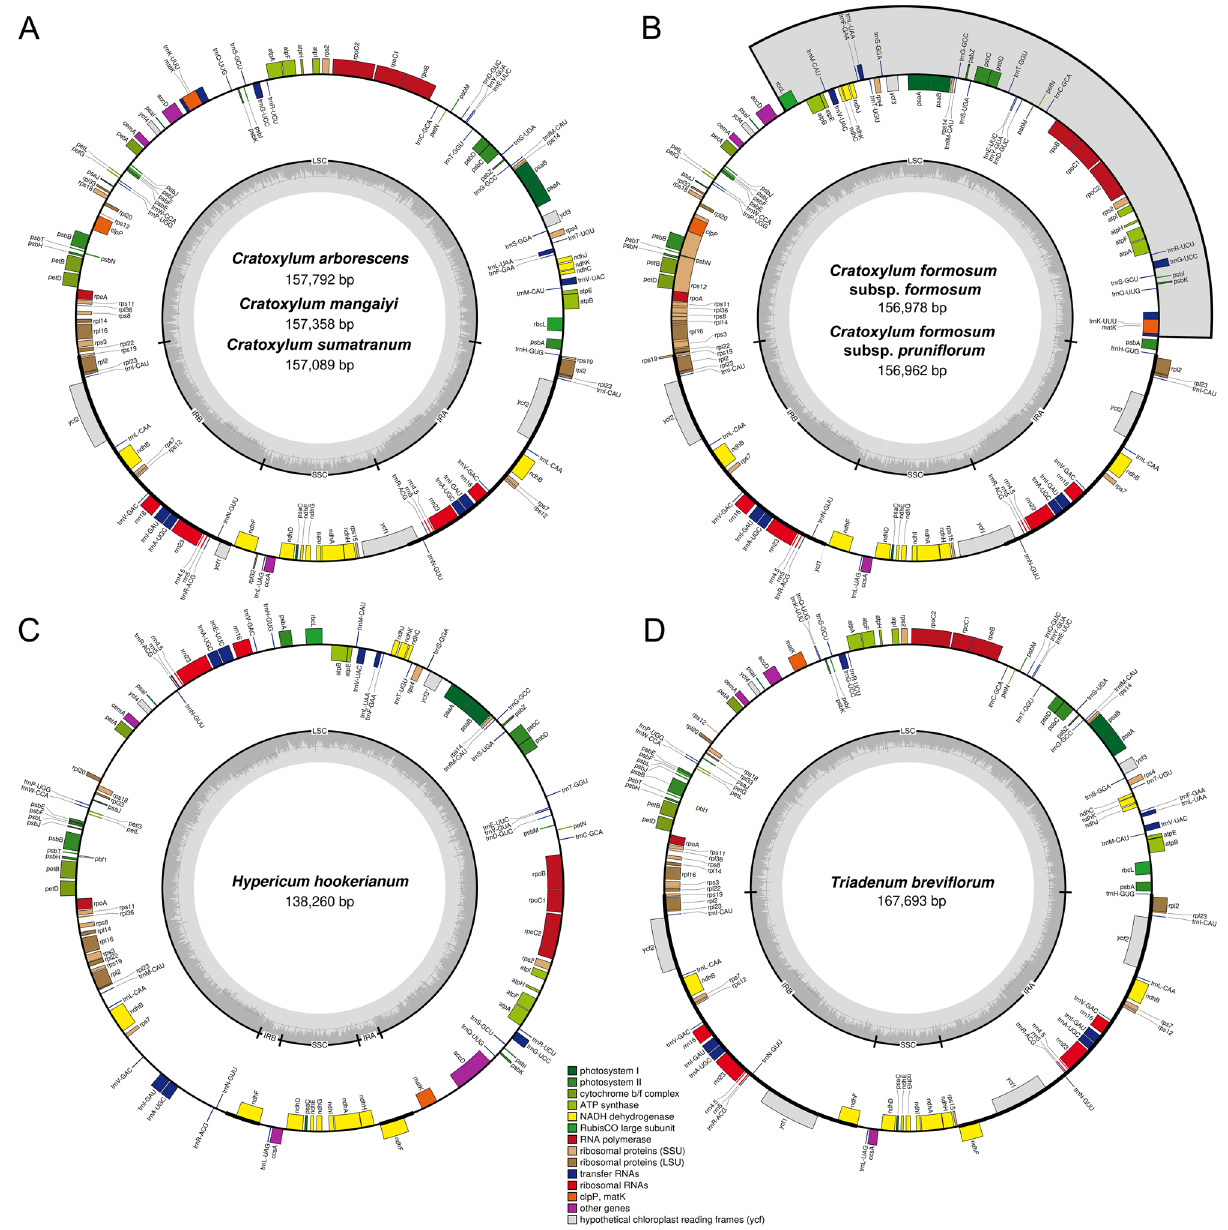
Figure 1. Genome structure and gene map of the seven taxa of Hypericaceae used in this study. Cratoxylum arborescens , C. maingayi , C. sumatranum ( A ); Cratoxylum formosum subsp. formosum , C. formosum subsp. pruniflorum ( B ); Hypericum hookerianum ( C ); Triadenum breviflorum ( D ). The inside circle genes are transcribed clockwise, and the outside circle genes are transcribed counter-clockwise. The color codes describe different functional groups of the genes. The thick lines indicate the boundary of the inverted repeats (IRA and IRB), demarcated between the large single-copy (LSC) and small single-copy (SSC) regions. The dark gray area in the inner circle represents genomic GC content, whereas light gray indicates AT